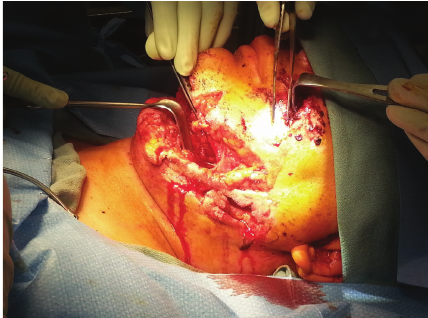
Figure 1: Clinical photograph illustrating severe facial trauma and soft tissue injury.